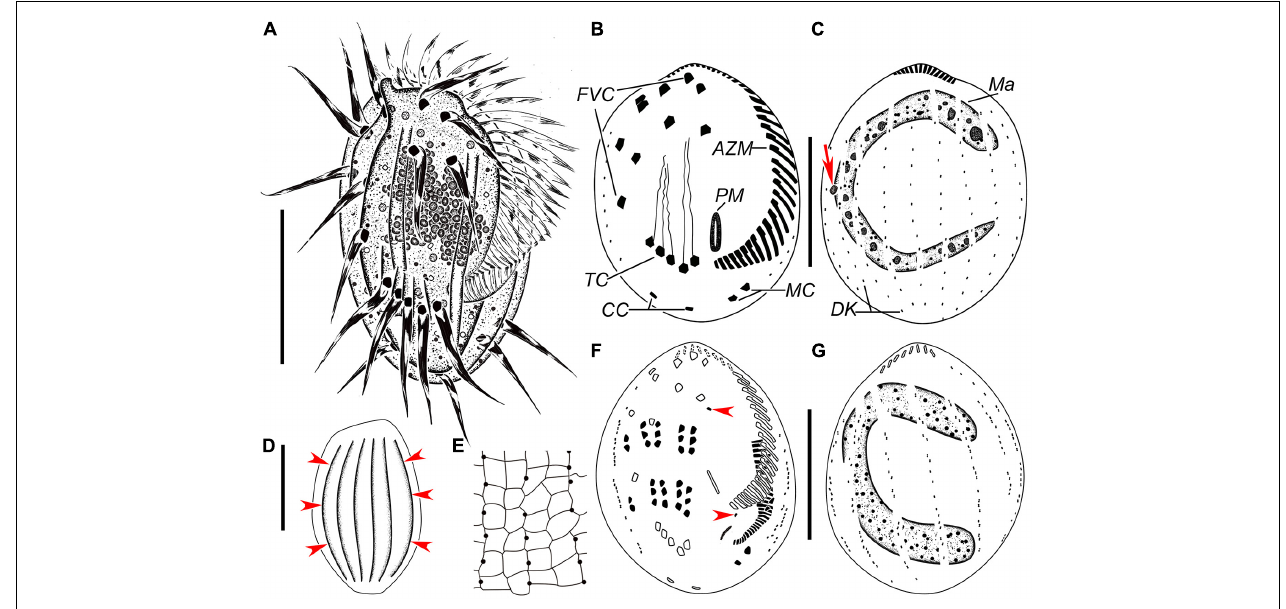
FIGURE 3 | Euplotes euryhalinus in vivo (A,D) , after protargol (B,C,F,G) and silver nitrate (E) staining. (A) Ventral view of a representative individual. (B,C) Infraciliature of ventral (B) and dorsal (C) sides of the same specimens, arrow in (C) marks the micronucleus. (D) Dorsal view, to show the conspicuous ridges (arrowheads). (E) Part of silverline system on the dorsal side. (F,G) Infraciliature of ventral (F) and dorsal (G) sides of the same middle divider. AZM, adoral zone of membranelles; CC, caudal cirri; FVC, frontoventral cirri; Ma, macronucleus; MC, marginal cirri; PM, paroral membrane; TC, transverse cirri. Bars, 25 µ m.